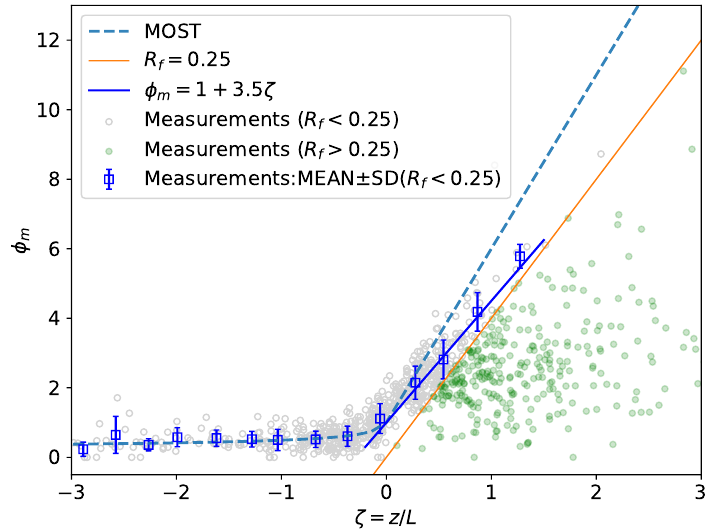
Figure 5. Plots of φ m as functions of ζ at 30 m above the ground level (AGL) for WD = 0 ◦ ± 10 ◦